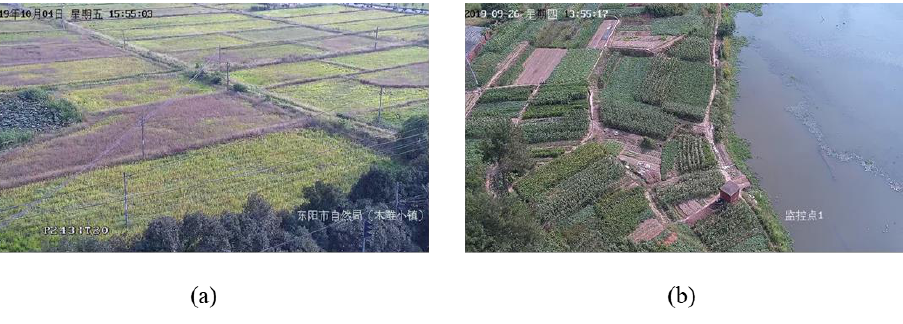
Figure 7. Scenes of the two datasets. ( a ) MDXZ and ( b ) JBWF.